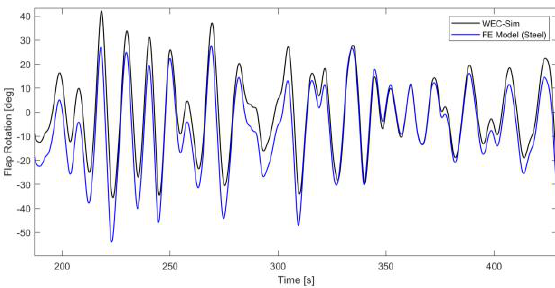
Fig. 11. Time series of flap pitch rotation – WEC-Sim's rigid- body approach (black) and dynamic uncoupled analysis (blue)